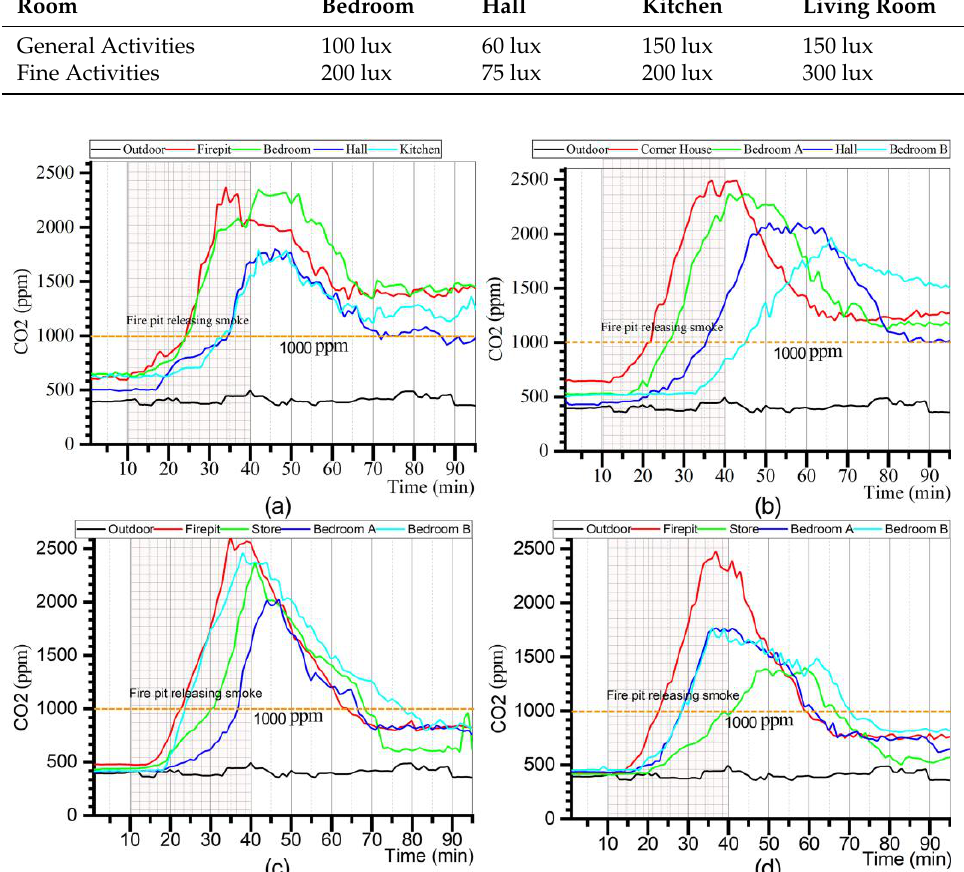
Table A3. Chinese indoor light intensity standards for the elderly.